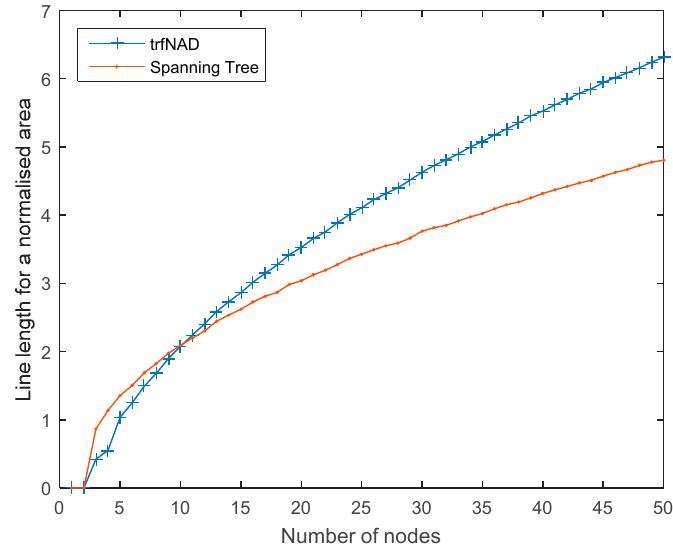
Figure 13. Normalized Line Length Comparison.